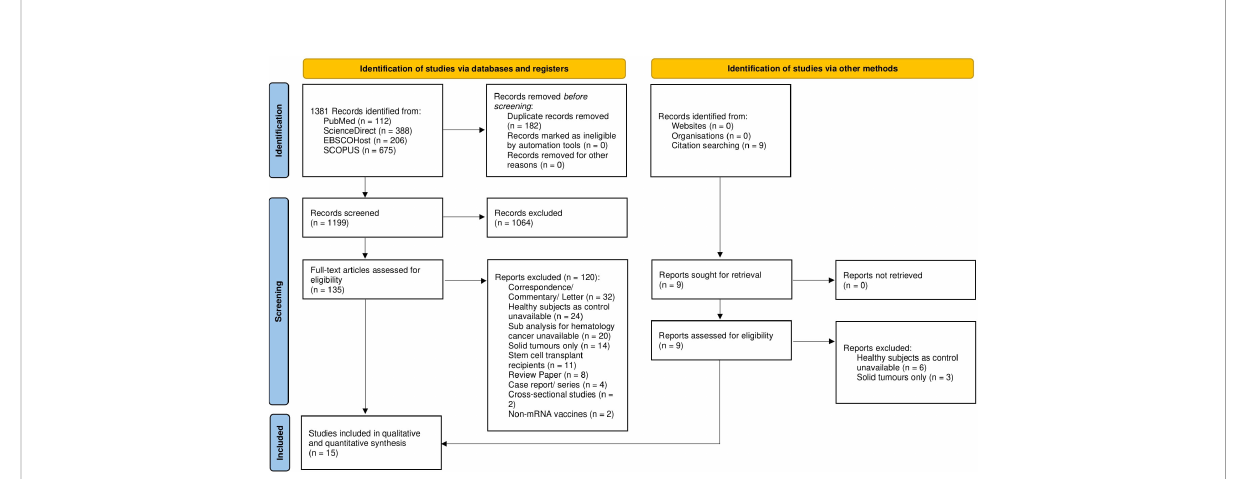
FIGURE 1 PRISMA fl ow diagram for systematic review and